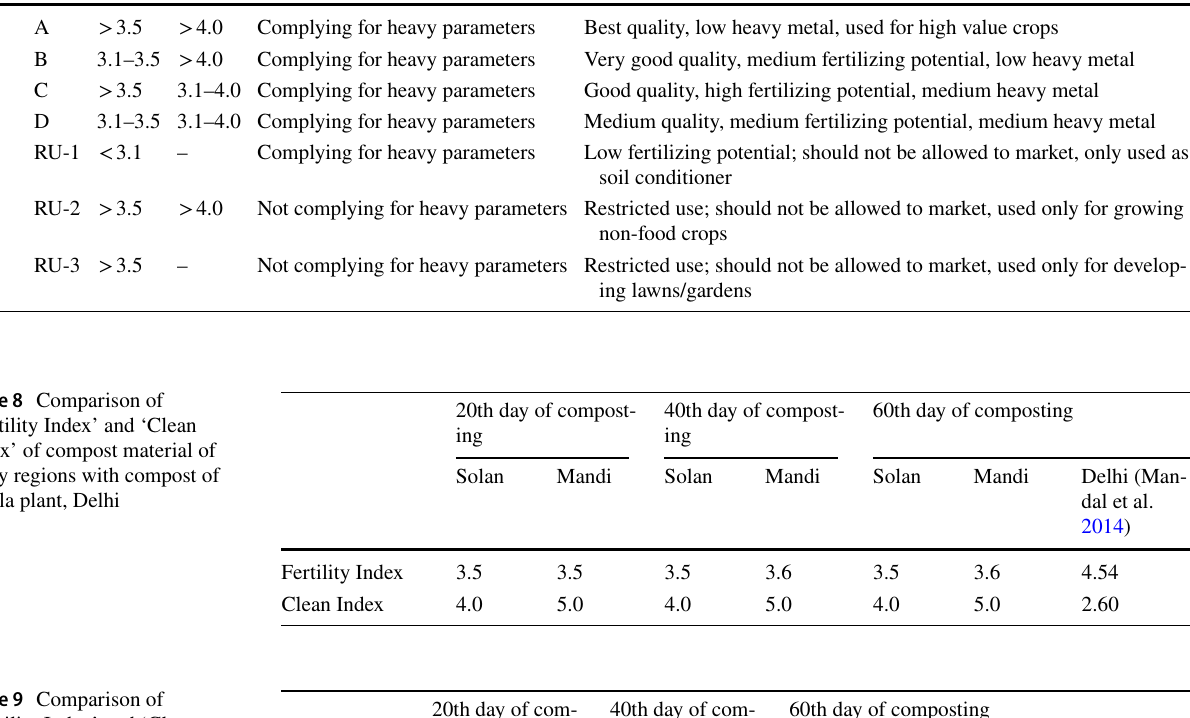
‘Fertility Index’ and ‘Clean Index’ of compost material of study regions with compost of Okhla plant,